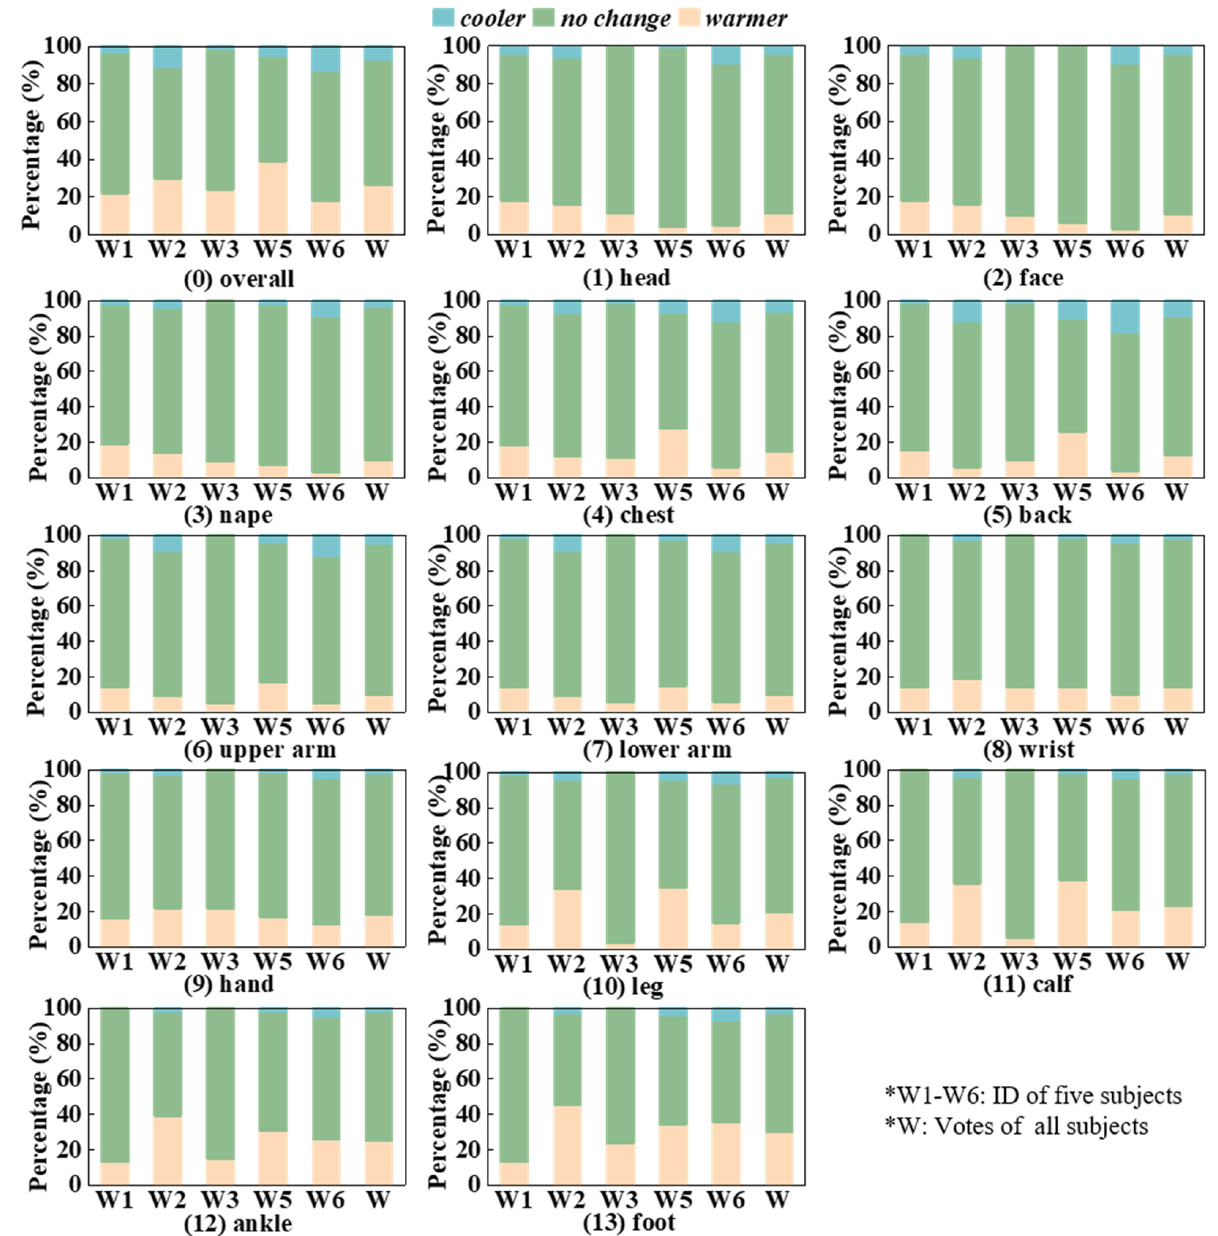
Figure 6. The local thermal preferences of the subjects.